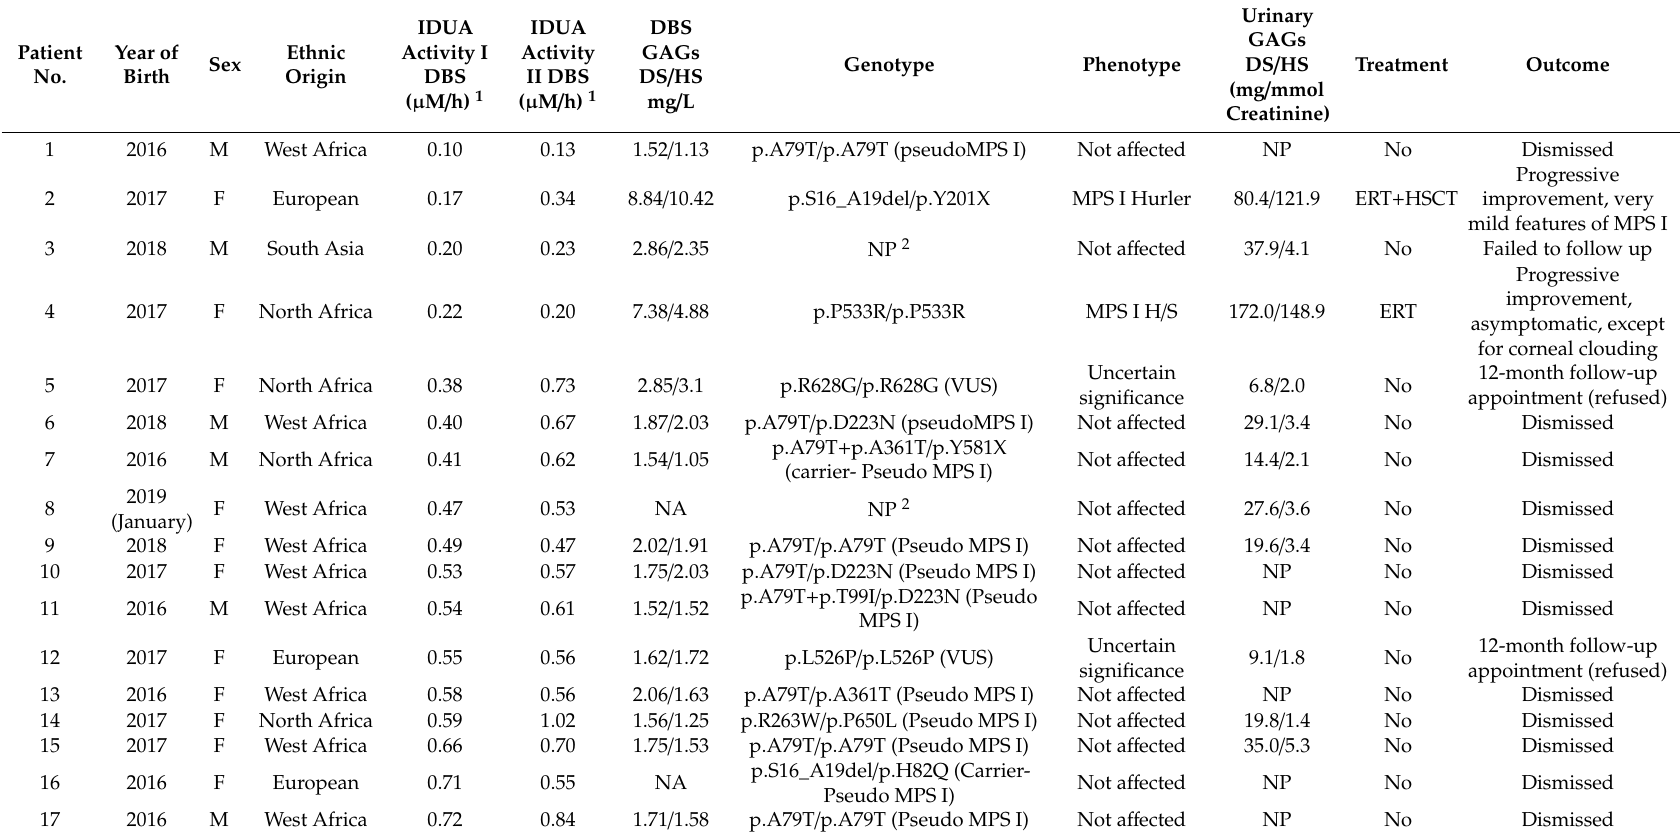
Table 3. Biochemical, molecular analysis and follow up of infants with positive NBS for MPS